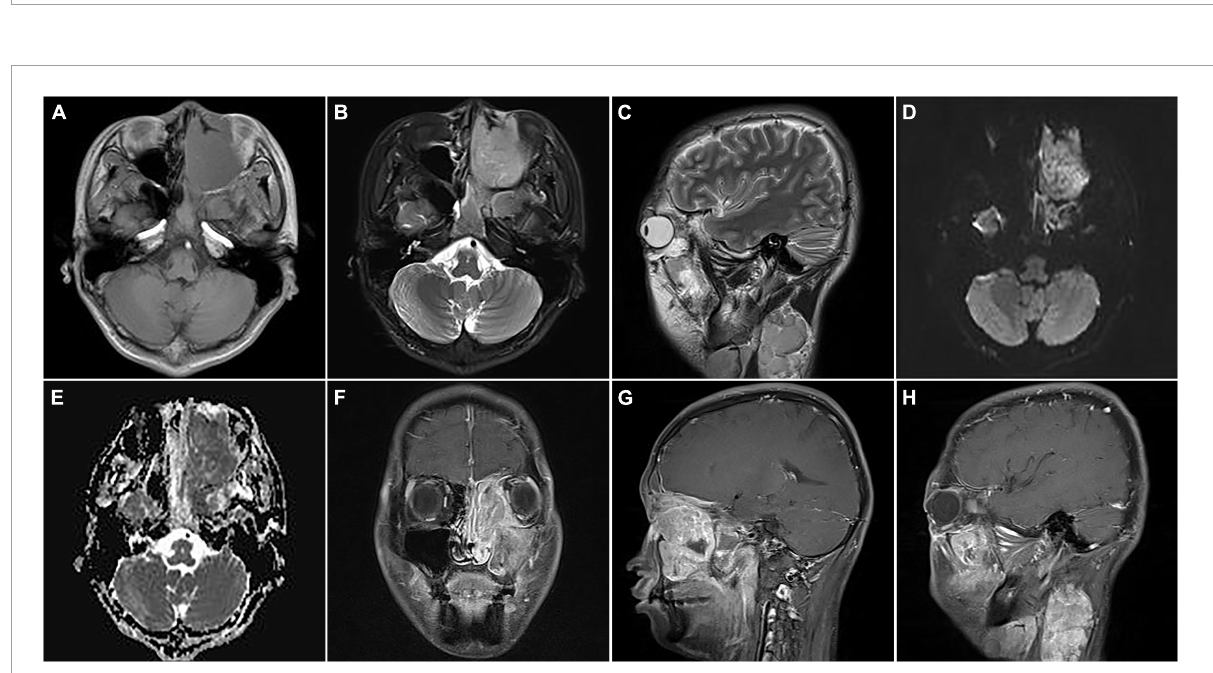
FIGURE2 Magnetic resonance images of nasal sinus ARMS in case 1. (A) Transverse T1-weighted image (T1WI) showed the lesions at the left nasal cavity and nasal sinus with hypointensity. (B) Transverse T2-weighted image (T2WI) showed the lesions at the left nasal cavity and nasal sinus with homogenous hyperintensity. (C) Sagittal T2WI showed a cervical lesion with heterogenous hyperintensity. The lesions showed hyperintensity on diffusion-weighted imaging (DWI) (D) and hypointensity apparent diffusion coefficient (ADC) images (E) . Coronal (F) and sagittal (G) enhanced images showed lesions in the nasal sinus with distinct enhancement. (H) Sagittal-enhanced images showed cervical lesions with distinct enhancement and clear